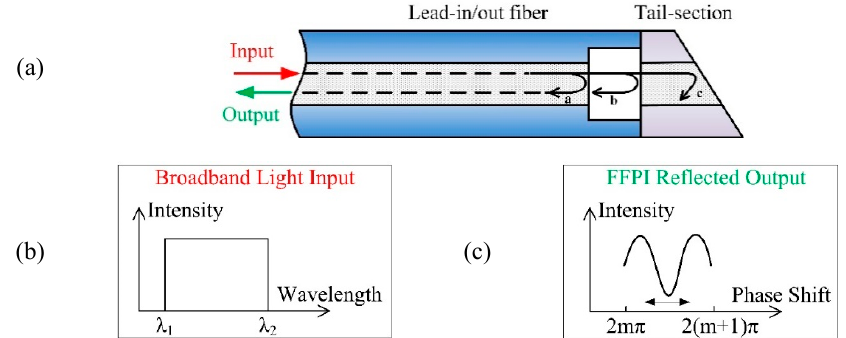
Figure 1. Concept of the proposed fiber Fabry–Pérot interferometric (FFPI) strain gauge, ( a ) design scheme, ( b ) input light spectrum, and ( c ) reflected output light spectrum.